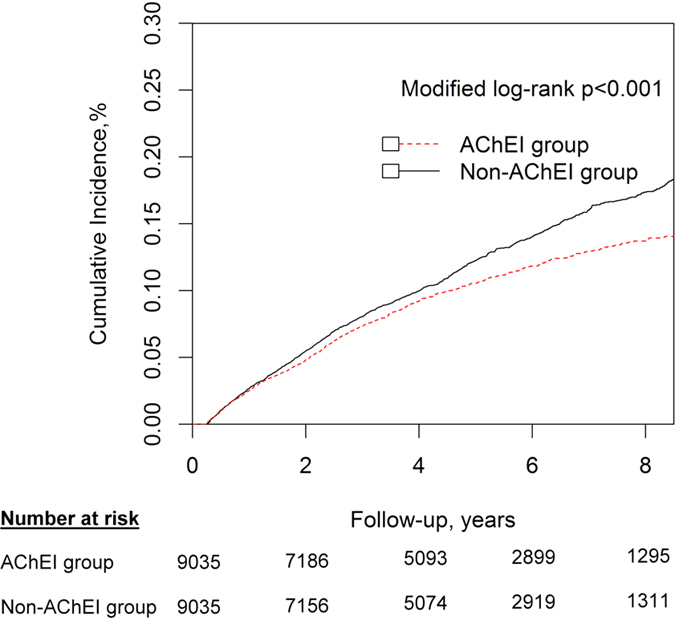
Cumulative incidences of acute coronary syndrome (ACS) for dementia patients who were treated with or without acetylcholinesterase inhibitors.Data were compiled after adjustment for competing mortality. For cumulative incidences of ACS, calculation and comparison of competing risk data ratios were conducted using modified Kaplan-Meier and Gray methods.